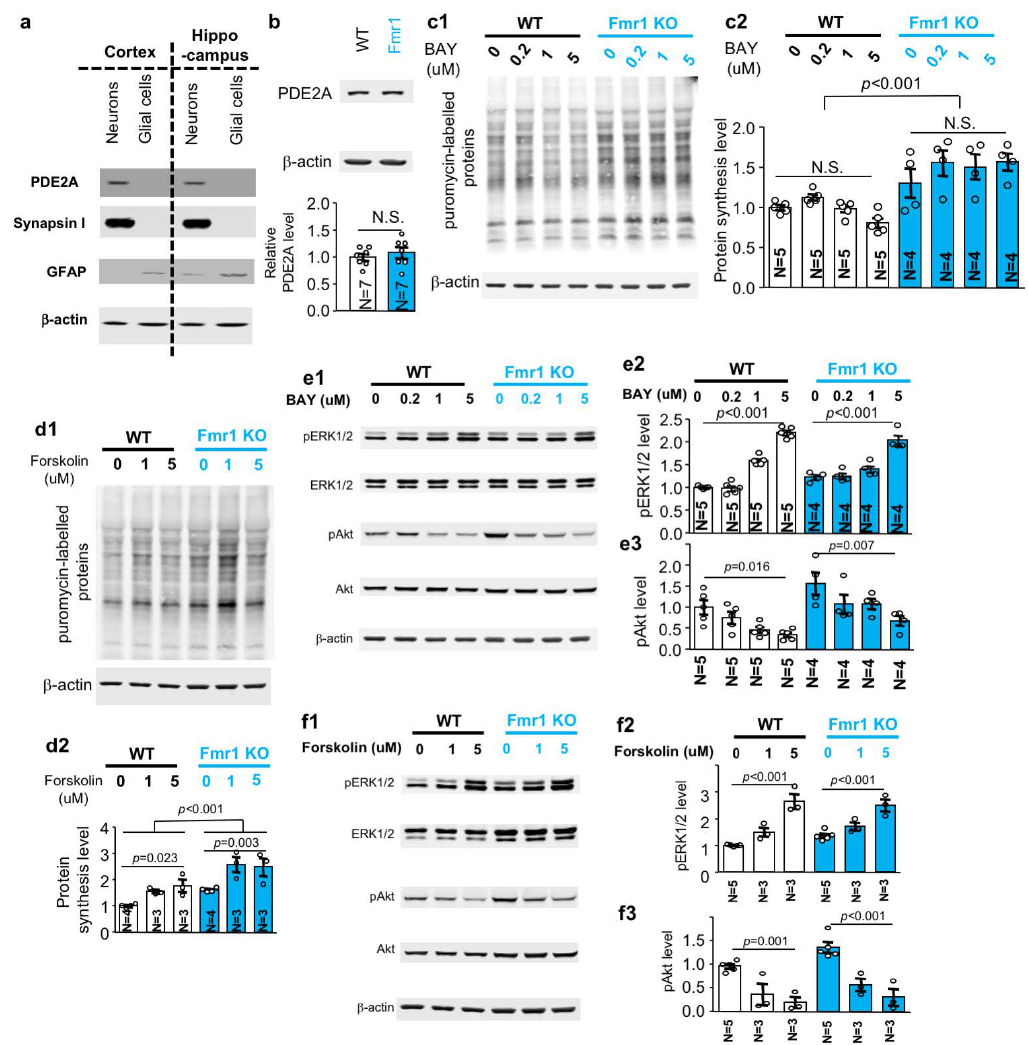
Figure 5. E ff ects of pharmacological inhibition of PDE2 and general activation of ADCY on protein synthesis and ERKERK 1 ⁄ 2 and Akt activity. ( a ). PDE2A is expressed in neurons but not in glial cells. As described in Figure 1a, the expression of PDE2A, synapsin I, GFAP, and β -actin in neuronal or glial preparations were determined by Western blot analysis. ( b ). PDE2A protein is expressed at comparable level in the hippocampus of 3-month old wild type (WT) and Fmr1 KO ( Fmr1 ) mice. The level of PDE2A was normalized with β -actin. ( c1 , c2 ) to ( f1 – f3 ), DIV 14 neurons from WT and Fmr1 KO mice were treated with PDE2 inhibitor BAY607550 (BAY) ( c1 , c2 , e1 – e3 ), and ADCY stimulator forskolin ( d1 , d2 , f1 – f3 ) at various concentrations (as indicated) for 1 h. ( c1 , c2 , d1 , d2 ). Protein synthesis was labelled with puromycin and determined by Western blot with antibody against puromycin. Representative results are shown in ( c1 , d1 ). Quantification (normalized with β -actin) is shown in ( c2 , d2 ). ( e1 – e3 , f1 – f3 ). The level of total ERKERK 1 ⁄ 2 , pERKERK 1 ⁄ 2 , total Akt, pAkt, and β -actin was determined by Western blot. The level of pERKERK 1 ⁄ 2 and pAkt was normalized to total ERKERK 1 ⁄ 2 and Akt, respectively. Representative results are shown in ( e1 , f1 ). Quantification is presented as average ± SEM. Quantification for pERKERK 1 ⁄ 2 is presented in ( e2 , f2 ). Quantification for pAkt is presented in ( e3 , f3 ). The N number indicated in the figure is the number of experiments performed with independent neuronal cultures. The p values were determined by Student’s t -test ( b ), two-way ( c1 , c2 ) to ( f1 – f3 ) ANOVA followed by post-hoc analysis. N.S.: not